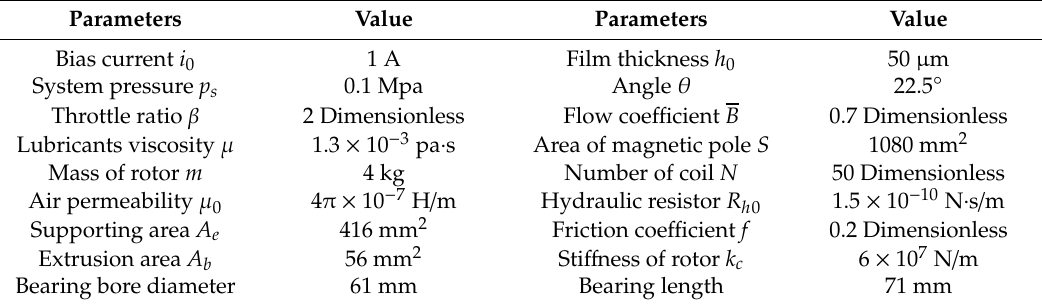
Table 1. Design parameters of MLDSB.